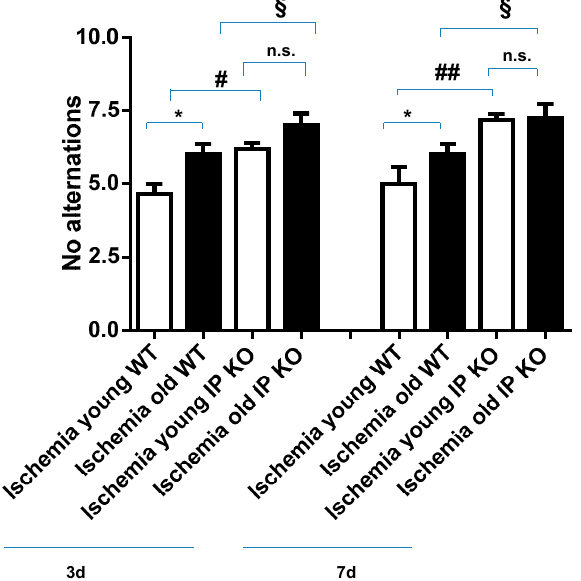
Figure 1. Number of “no alternations” in the T-maze spontaneous alternation test (10 trials) after 12 min global ischemia and 3-day or 7-day reperfusion. “No alternations” was assessed in both young and aged ischemic IP receptor knock out (IP KO) mice compared to their ischemic wild-type (WT) controls ( * p < 0.05, § p < 0.05, # p < 0.05